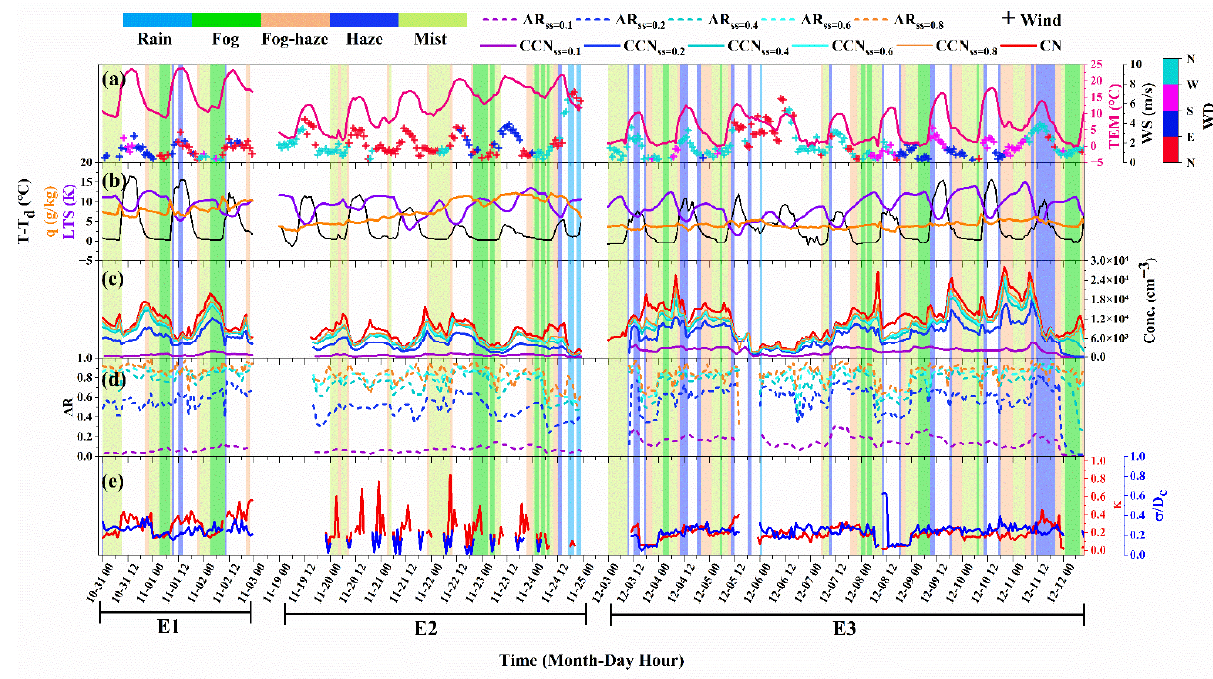
Figure 2. Time series of hourly ‐ averaged ( a ) temperature (TEM), wind direction (WD) and wind speed (WS), ( b ) low tropospheric stability (LTS) and specific humidity (q), ( c ) number concentrations of condensation nuclei (CN) and cloud condensation nuclei (CCN), ( d ) aerosol activated ratio (AR) and ( e ) hygroscopicity ( κ ) and chemical heterogeneity ( σ / D c ) of particles during three typical low ‐ visibility event periods (E1: 31 October to 2 November, E2: 19 November to 24 November and E3: 3 Dec. to 12 Dec.). The background colors refer to the type of weather conditions.